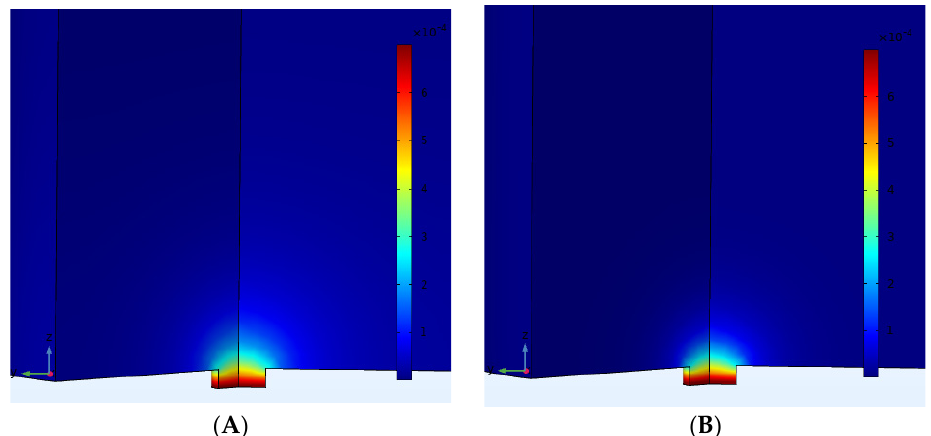
Figure 21. Color diagrams of the near-electrode area concentration at the moment of reaching the end of the first branch of the voltammetric waveform for sweep speeds of 100 ( A ) and 1000 ( B ) mV/s.